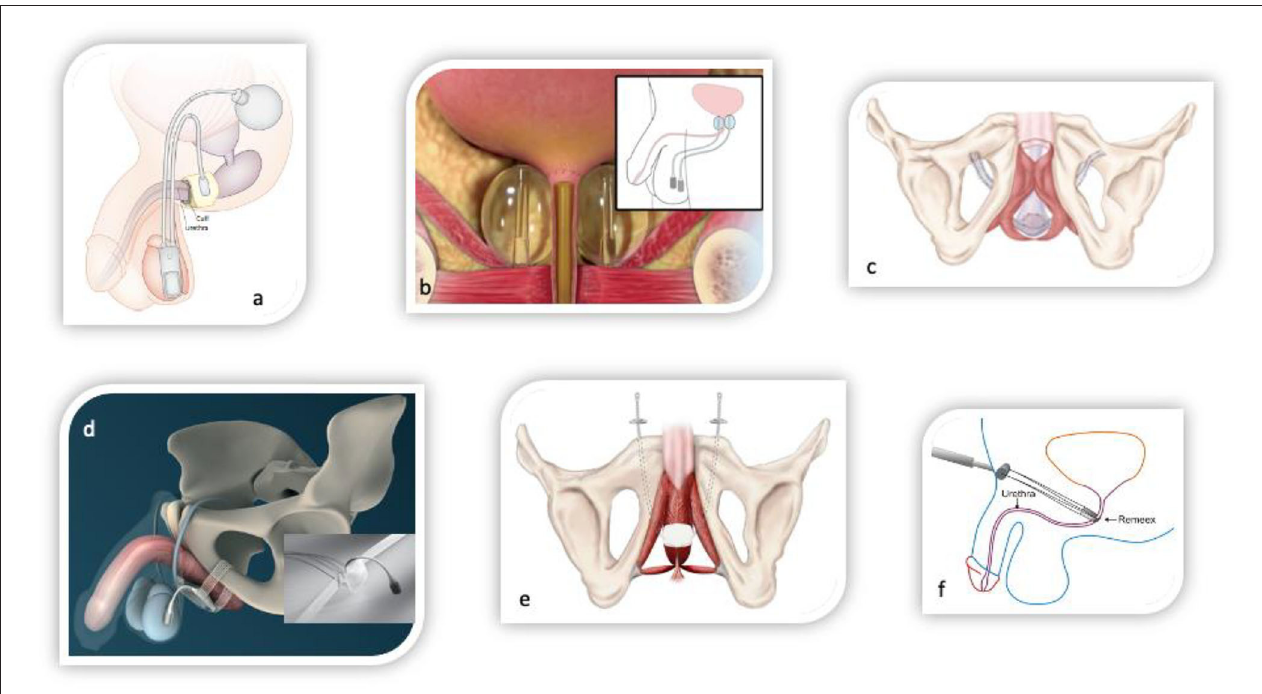
FIGURE 3 | Surgical devices for the treatment of male stress urinary incontinence. (a) Circumferential compressive three-piece artificial urinary sphincter AMS800 (Boston scientific, USA). (b) Non-circumferential compressive device ProACT (UroMedica, USA). (c) Fixed male sling AdVanceXP (Boston Scientific, USA). (d) Adjustable male sling ATOMS (A.M.I., Austria). (e) Adjustable male sling Argus (Promedon, Argentina). (f) Adjustable male sling Remeex (Neomedic, Spain).